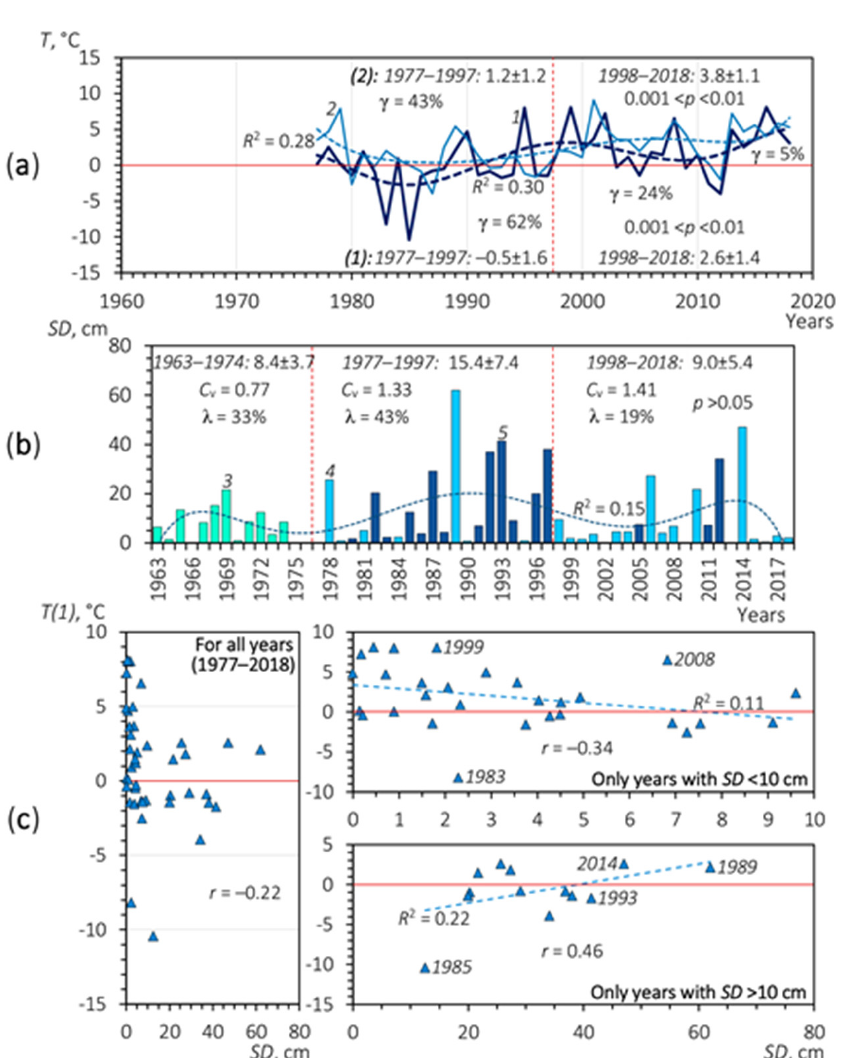
Figure 12. Contemporary long-term changes in March temperature of the topsoil ( ≤ 10 cm deep) ( a ) and snow cover depth ( SD ) ( b ) in February, according to data from the Stavropol’s meteorological station (see Figure 1). 1 —averagely for the first 10-day period of March; 2 —averagely for the second 10-day period of March; R 2 —the coefficient of approximation for the sixth-degree polynomial trend line (the linear trend for SD / T correlation); γ —the proportion of years with temperatures below 0 ◦ C in the corresponding period; λ —the proportion of years with a snow cover depth in February of more than 10 cm in the corresponding period; C v —the coefficient of variation; r —the coefficient of linear correlation. On the SD diagram ( c ), qualitative assessment of the possibility of water runoff formation caused by snow melting on the soil (based mainly on combined temporal dynamics of T(1) and SD during 1977–2018) is: 3 —not assessed owing to lack of data on T(1) until 1977; 4 —low and very low; 5 —high and very